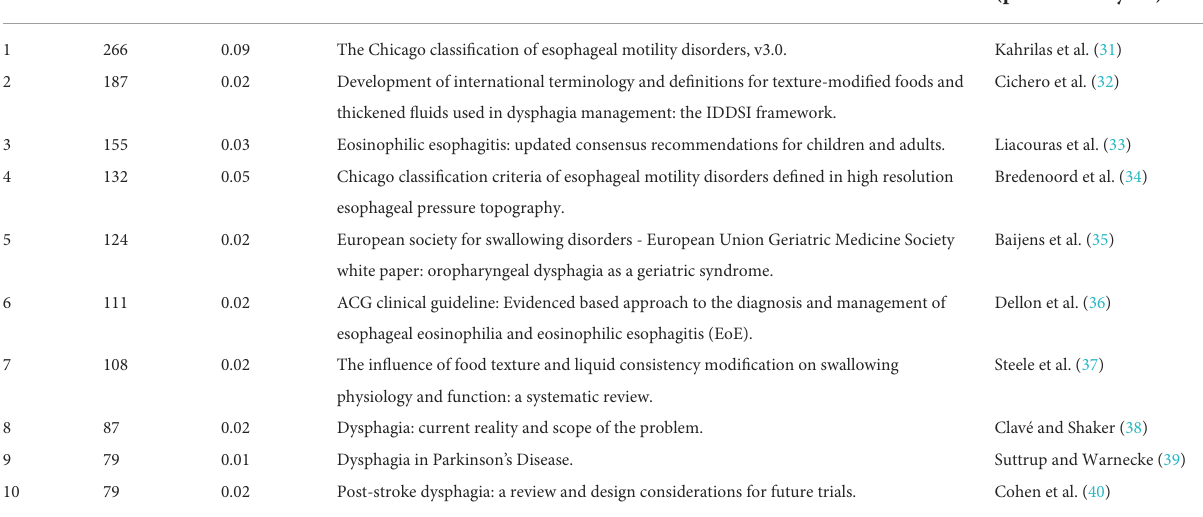
TABLE 6 The top ten cited references and centrality in the research field of dysphagia from 2012 to 2022. Ranking Frequency Centrality Cited